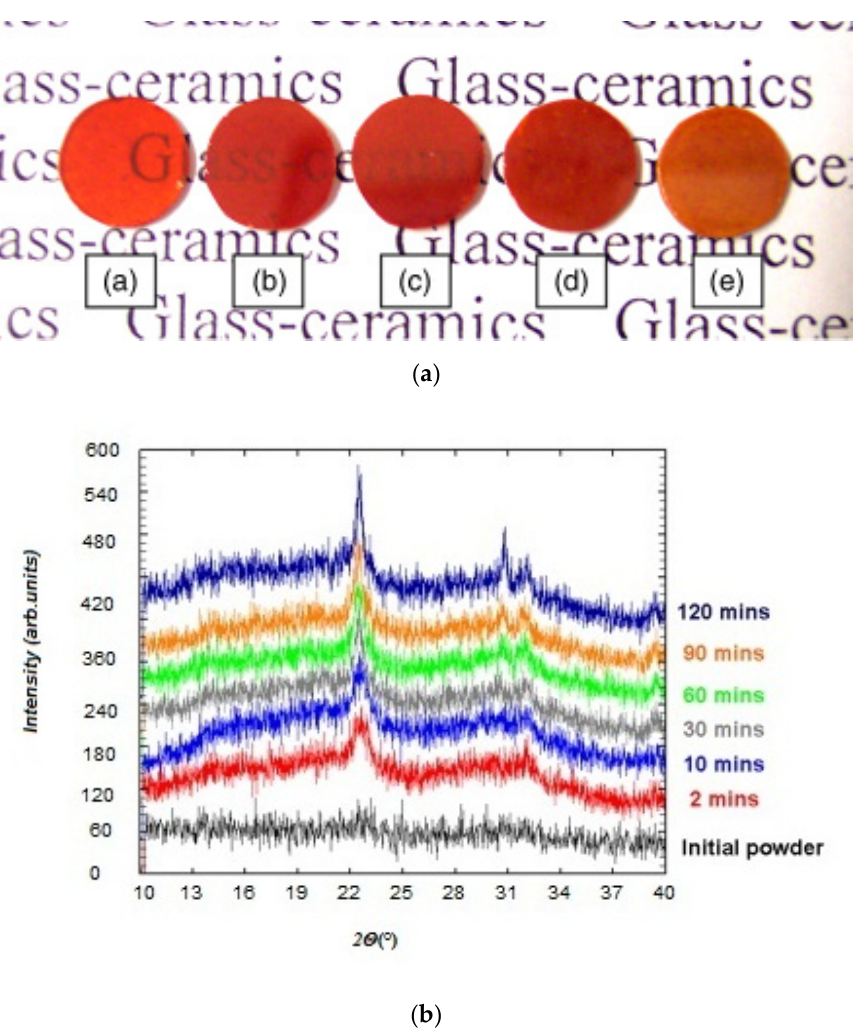
Figure 4. ( a ) Visual aspect of glass-ceramics samples obtained from the 62.5GeS 2 –12.5Sb 2 S 3 – 25CsCl-based glass powder for, respectively, spark plasma sintering treatment times of (a) 10 min, (b) 30 min, (c) 60 min,(d) 90 min, and (e) 120 min at 2901 ◦ C under 100 MPa and ( b ) corresponding XRD patterns. Reprinted with permission from the Journal of the American Ceramic Society [56].